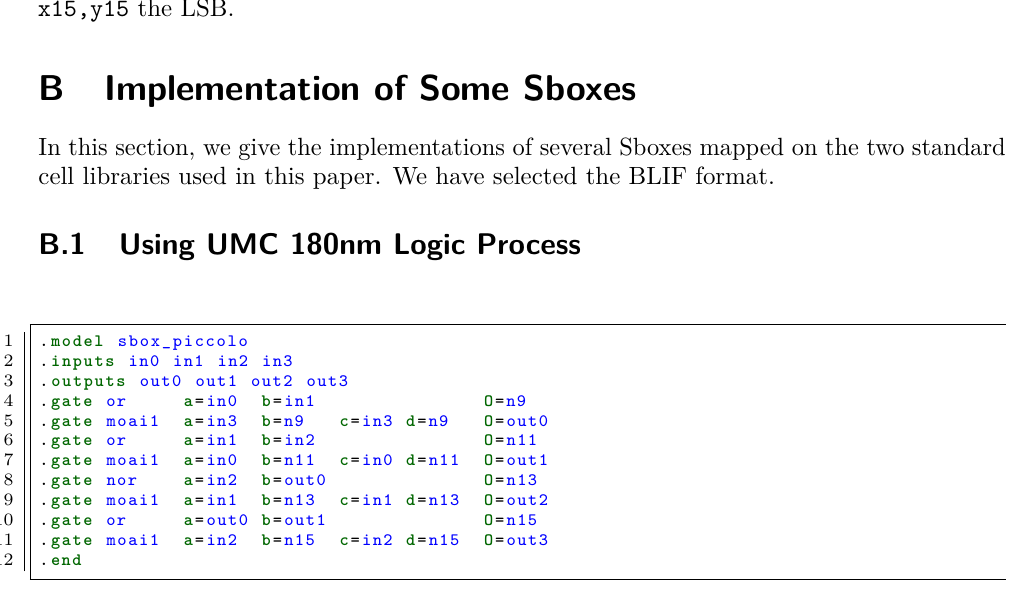
Figure 3: Implementation of the matrix M 4 ,n, 4 . The input vector is stored in x0,x1,...,x15 and output vector in y0,y1,...,y15 where x0,y0 are the MSB and x15,y15 the LSB.